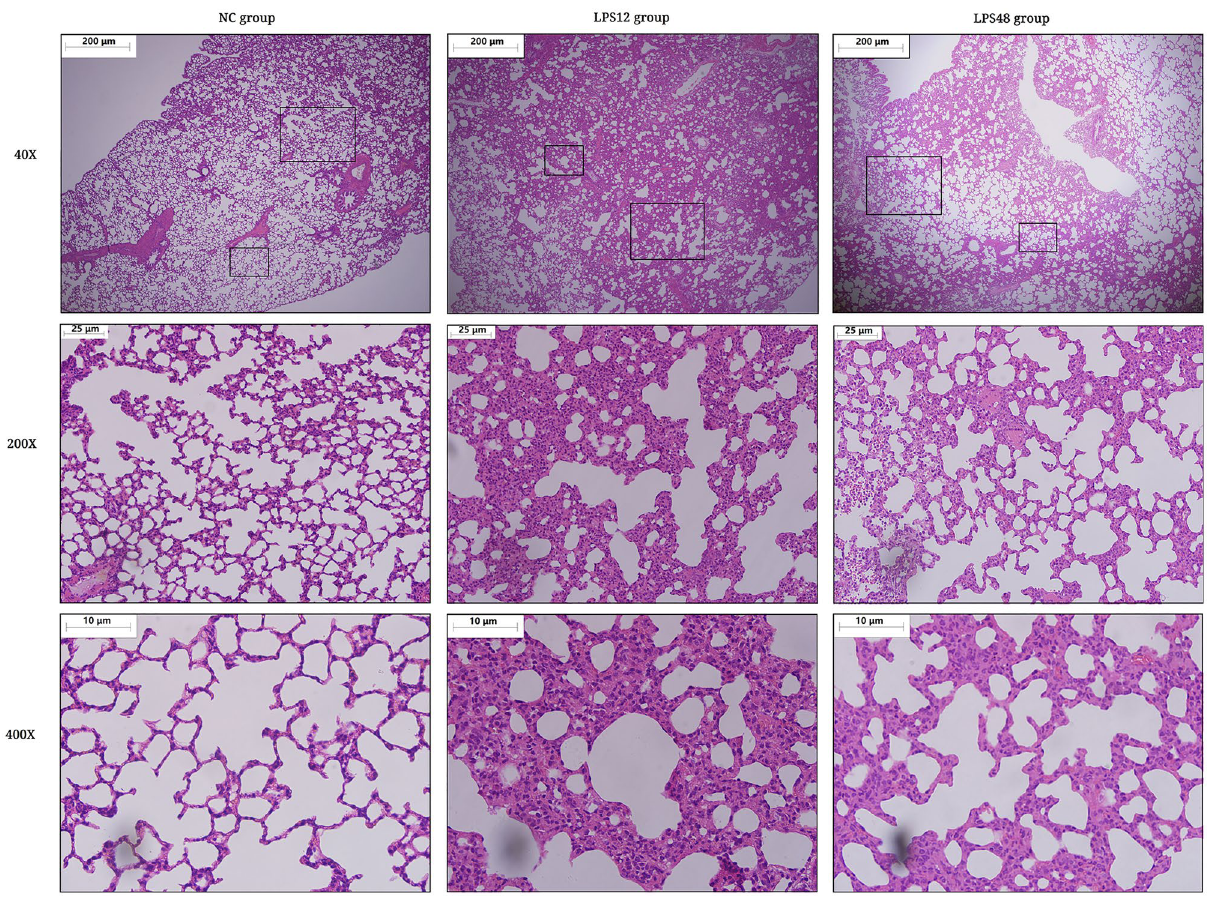
Figure 1. Representative H&E-stained lung sections showing morphological changes in lung tissue. The Control group presented normal architecture with no damage to the lung tissue. In the LPS12 group, the tissue showed interalveolar septum thickening, irregular distribution of air spaces, pulmonary interstitial edema, and inflammatory cell infiltration. In the LPS48 group, the tissue still showed perivascular and peribronchial inflammatory infiltration, but the alveolar architecture and histological changes were slightly